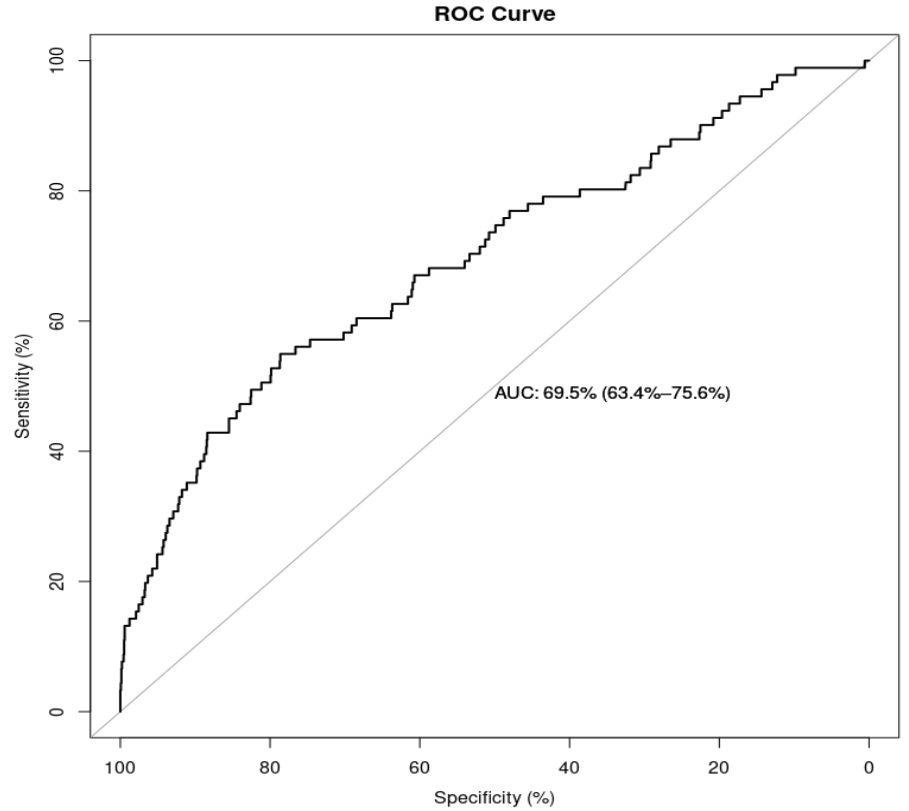
Figure 2. ROC (receiver operating characteristic) curve of the logistic regression model.